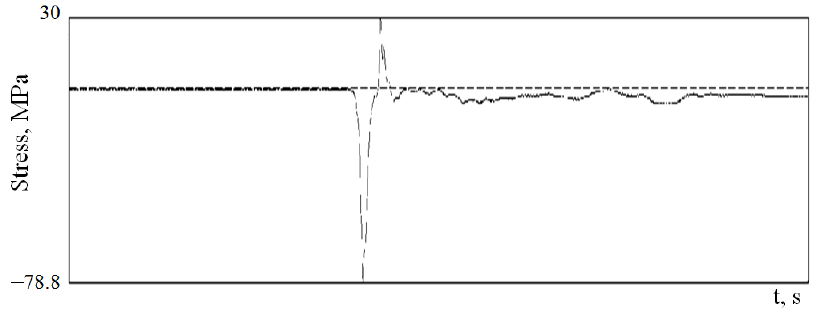
Figure 16. Maximum equivalent stresses (Strain gauge 5).